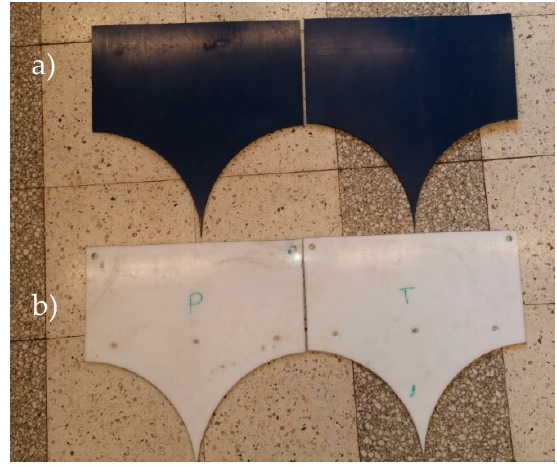
Figure 4. A view of cut-out slide boards: ( a ) made of the UHMW-PE material and ( b ) made of the POM C material.